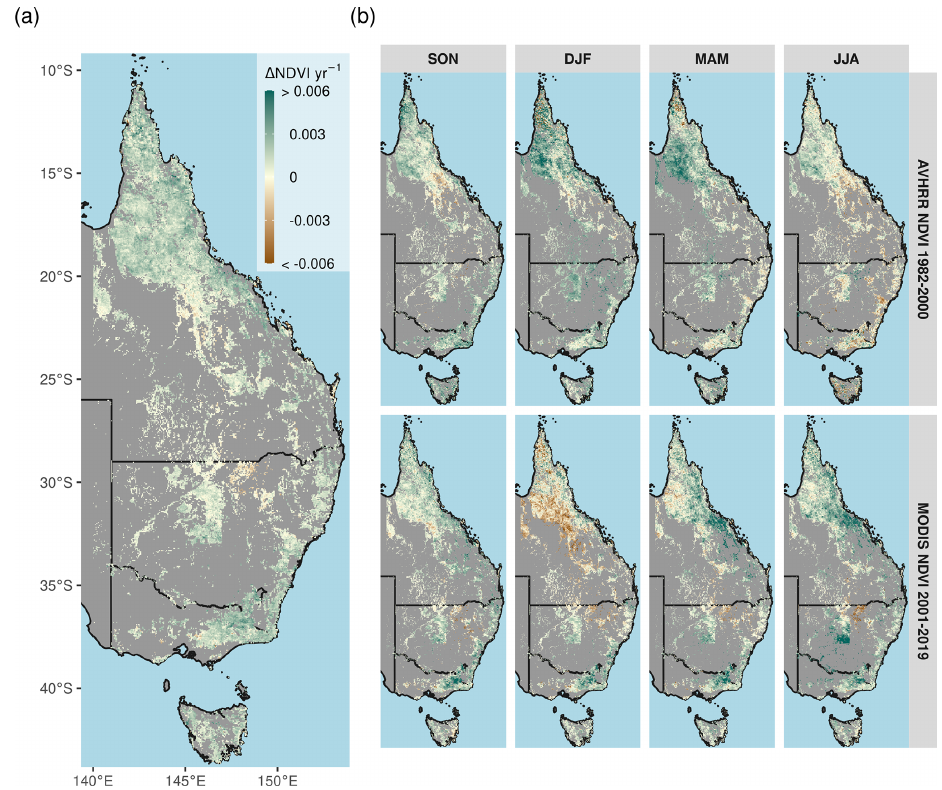
Figure 3. Overall long-term NDVI change and change shown by satellite epoch and season. (a) The annual rate of NDVI change from the merged satellite record spanning 1982–2019. The seasonal AVHRR NDVI between 1982–2000 ( b , top row) and MODIS NDVI between 2001–2019 ( b , bottom row). Non-woody ecosystem regions are masked in gray. A notable browning trend is evident at the interface of the Grassland and Arid regions during DJF of the MODIS time period. Note: season abbreviations correspond to September–October (SON), December–February (DJF), March–May (MAM), and July–August